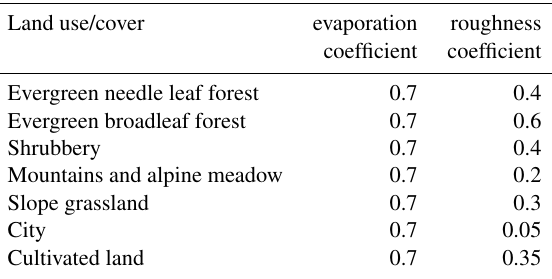
Table 2. The initial values of land use/cover-related